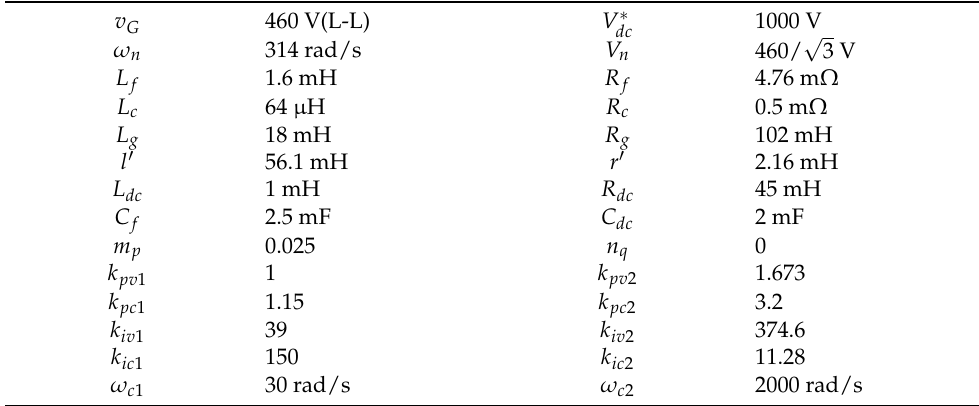
Table 1. Parameters of the PVSC system under the study.